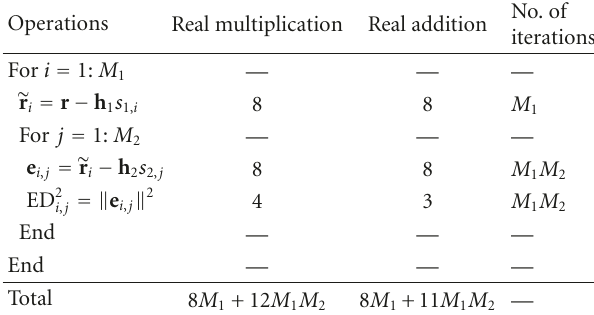
Table 1: Complexity analysis for the optimal MLD scheme ( N t = N r = 2, per one subcarrier).